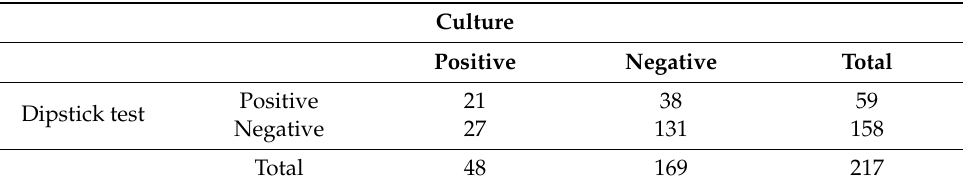
Table 2. Sensitivity, specificity, positive predictive value and negative predictive value for urinary dipstick test.